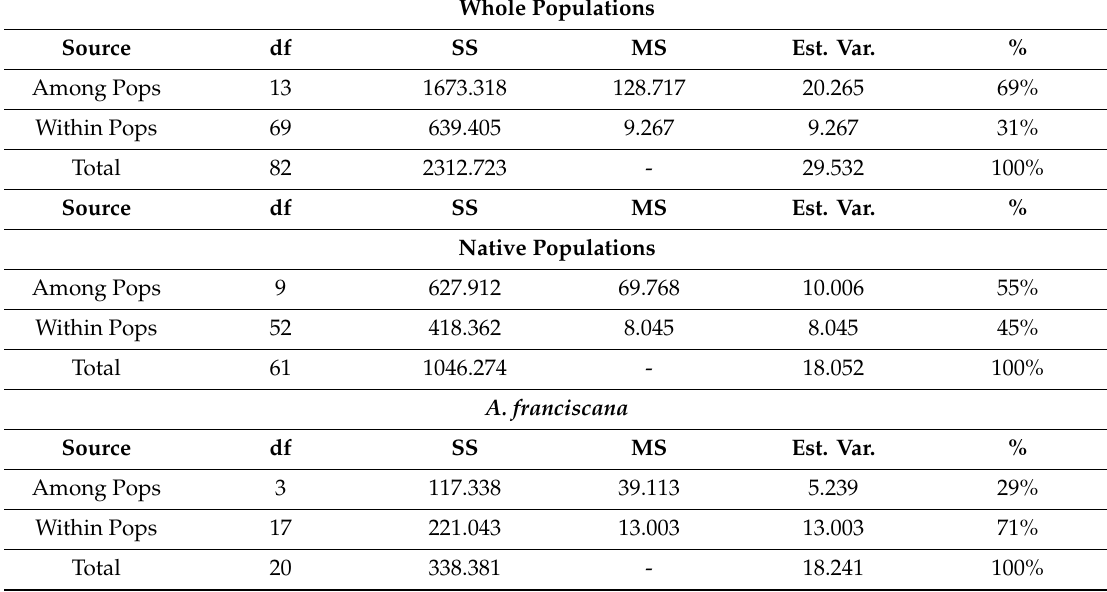
Table 9. Molecular variation (within and among populations) for examined populations by AMOVA based on ISSR